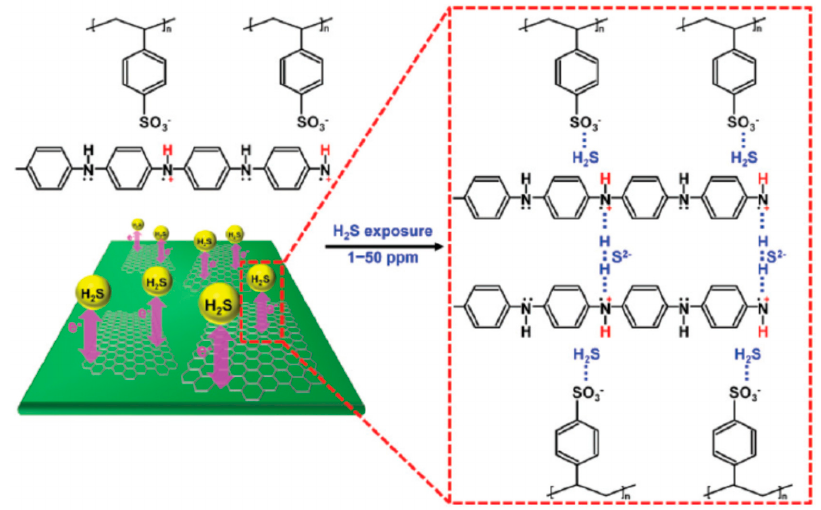
Figure 3. Possible mechanism for molecular interactions between the PSS-doped PANI/graphene nanocomposites and H 2 S gas molecules. Reproduced from [64], with permission from the Royal Society of Chemistry.